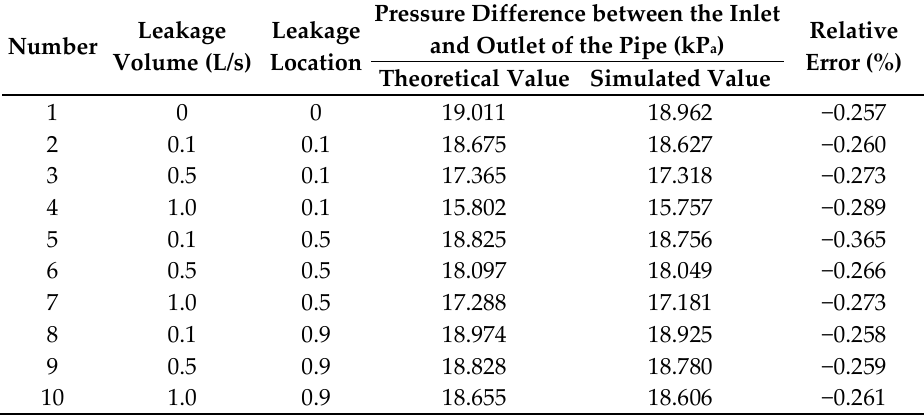
Table A1. Pressure difference between the inlet and outlet of a pipe, as determined by two